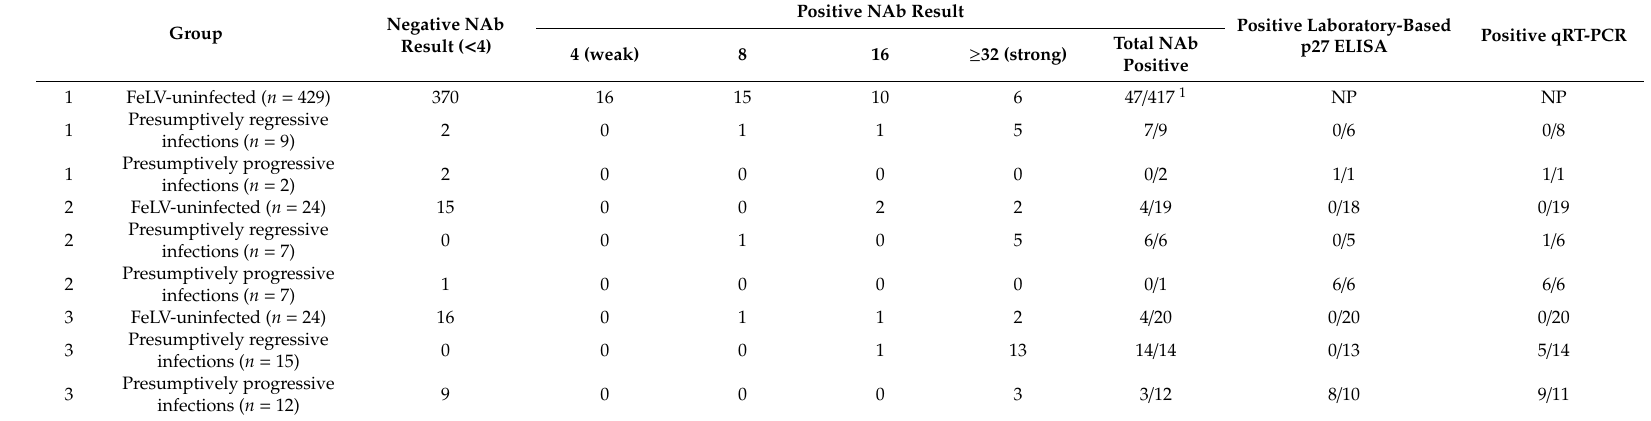
Table 3. Summary of results from NAb testing, laboratory-based p27 testing, and qRT-PCR testing. Not all samples were available for testing. NP = not